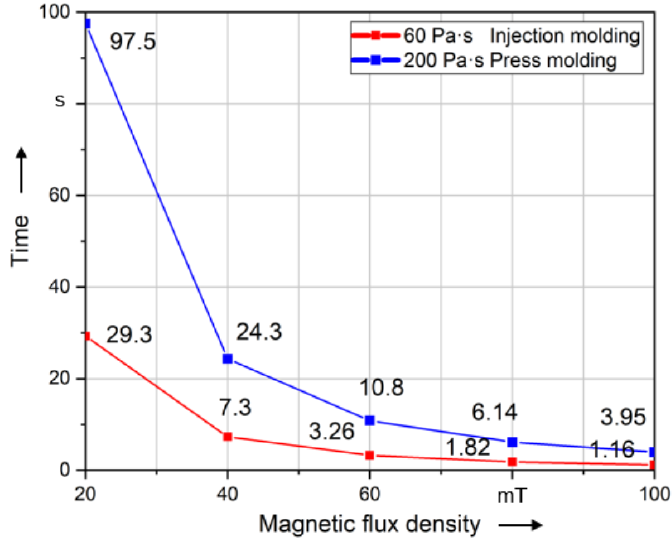
Figure 14. Time required to align long fibers (5000 µm) of different magnetic flux densities to 99% of 90°.